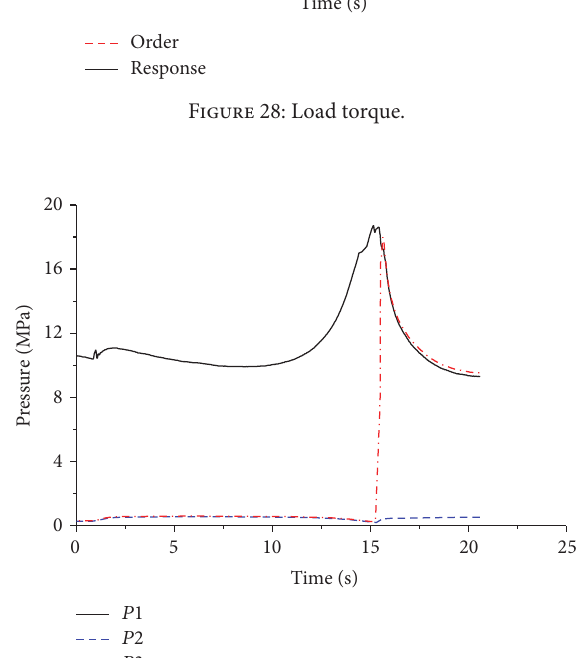
Figure 27: Steer angle.